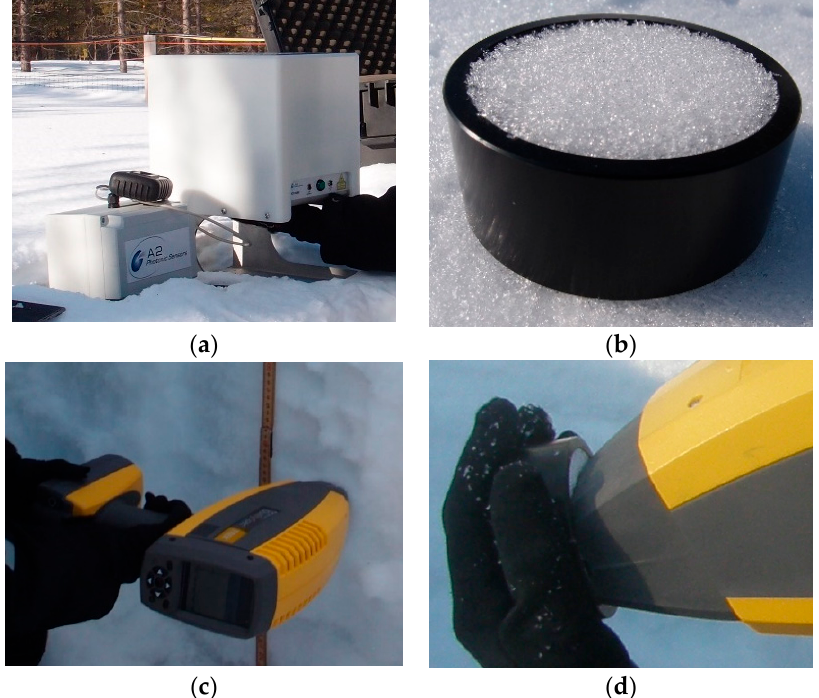
Figure 2. ( a ) The IceCube measurement; ( b ) the IceCube sample; ( c ) the QualitySpec Trek (QST) measurement from the snowpack vertical profile; ( d ) the QST measurement from sampled snow.